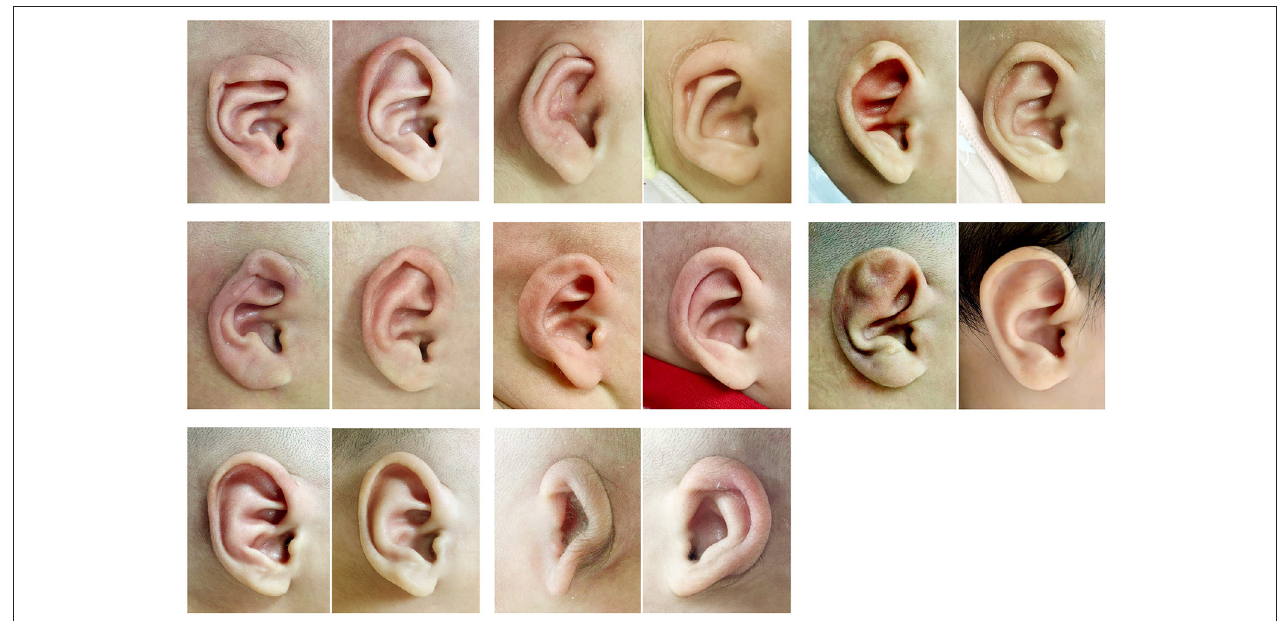
FIGURE 4 | Pretreatment (left in each pair) and posttreatment (right in each pair) photographs of a child with a lop ear (top left), cryptotia (top middle), cup ear (top right), helical rim deformity (middle left), constricted ear (middle middle), Stahl’s ear (middle right), conchal crus (lower left), and a grade I microtia (lower